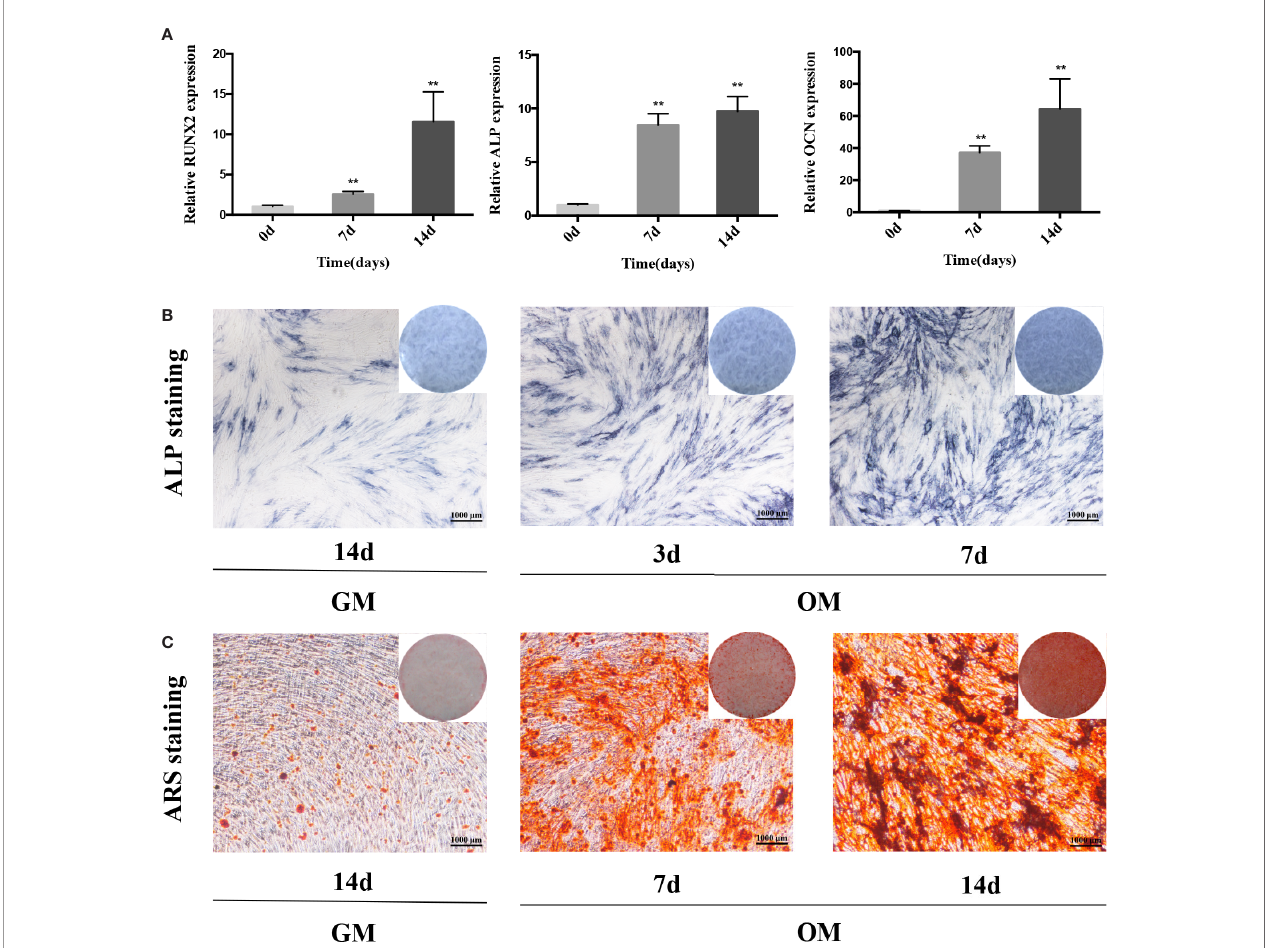
FIGURE 1 | The osteogenic induction of hPDLSCs. (A) : The relative expression of osteogenic makers namely RUNX2, ALP and OCN was determined by qRT-PCR during the osteogenesis of hPDLSCs for 0, 7 and 14 days. RNA expression at the above-mentioned time period was normalized to day 0. GAPDH was used as an internal control. (B) : The images of ALP staining in hPDLSCs cultivated in GM or OM for 3 and 7 days. (C) : The images of ARS staining in hPDLSCs cultivated in GM or OM for 7 and 14 days. **p < 0.01. hPDLSCs, human periodontal ligament stem cells; GAPDH, glyceraldehyde 3-phosphate dehydrogenase; RUNX2, runt-related transcription factor 2; ALP, alkaline phosphatase; OCN, osteocalcin; qRT-PCR, quantitative reverse-transcription polymerase chain reaction; ARS, Alizarin red S; GM, growth medium; OM, osteogenic